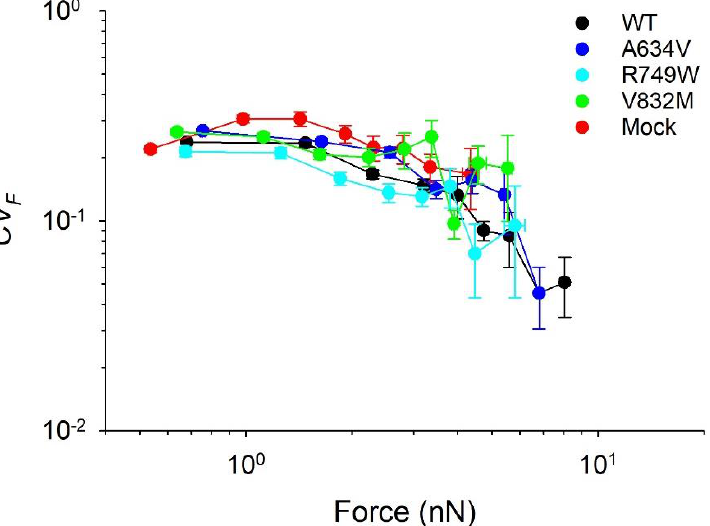
Figure 5. Impact of E-cadherin variants on tensional homeostasis of focal adhesions. With increasing of the time-averaged focal adhesions traction forces, their coefficient of variation ( CV F ) decreases. Different colors correspond to different cell types cultured on the combination of Fibronectin and Vitronectin micropatterns: WT cells (black), A634V cells (blue), R749W cells (cyan), V832M cells (green), and Mock cells (red). Data show mean ± standard error.